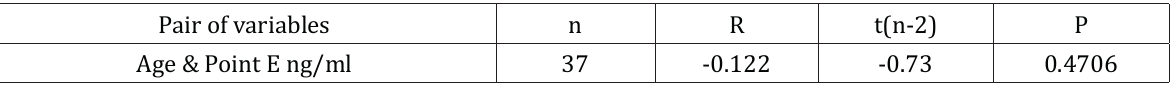
At the end of the study, the average metalloproteinase level was higher in patients of sex-code 2 than in patients of sex-code 1. The difference was not statistically significant (p>0.05). Table 13. Spearman Rank correlations between age and the concentration of MMP-9 at the end point of the